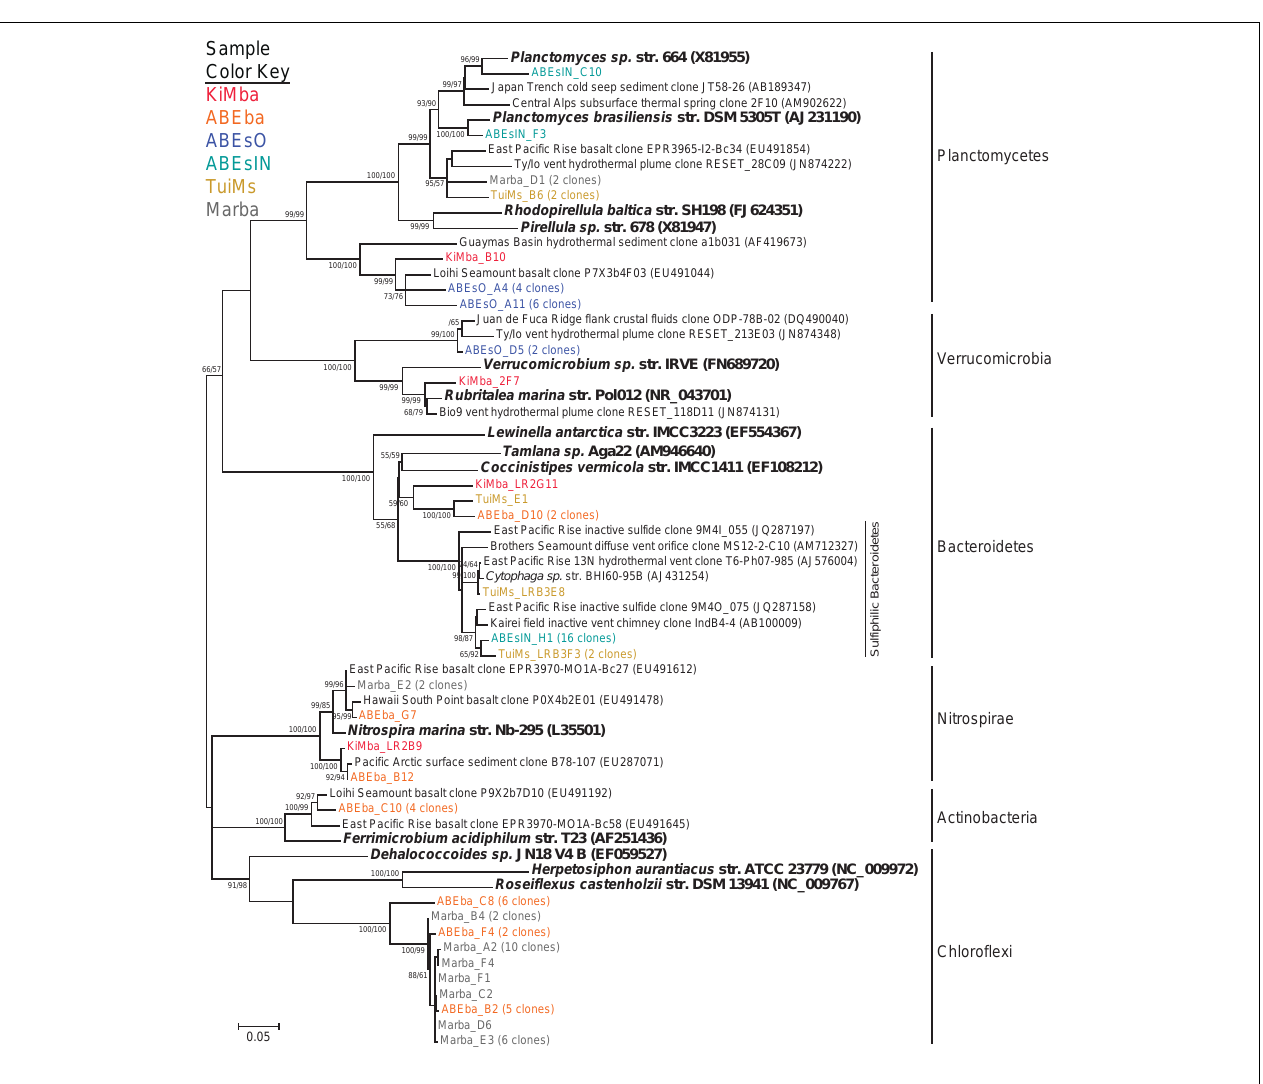
replicates.The same alignment was used to generate a neighbor-joining tree with the maximum composite likelihood method and 1000 bootstrap replicates. Nodes where both methods agree and bootstrap support was > 50% are indicated with bootstrap values from the neighbor-joining tree on the left and the maximum likelihood tree on the right. Samples are color-coded and no representative clones are shared across multiple